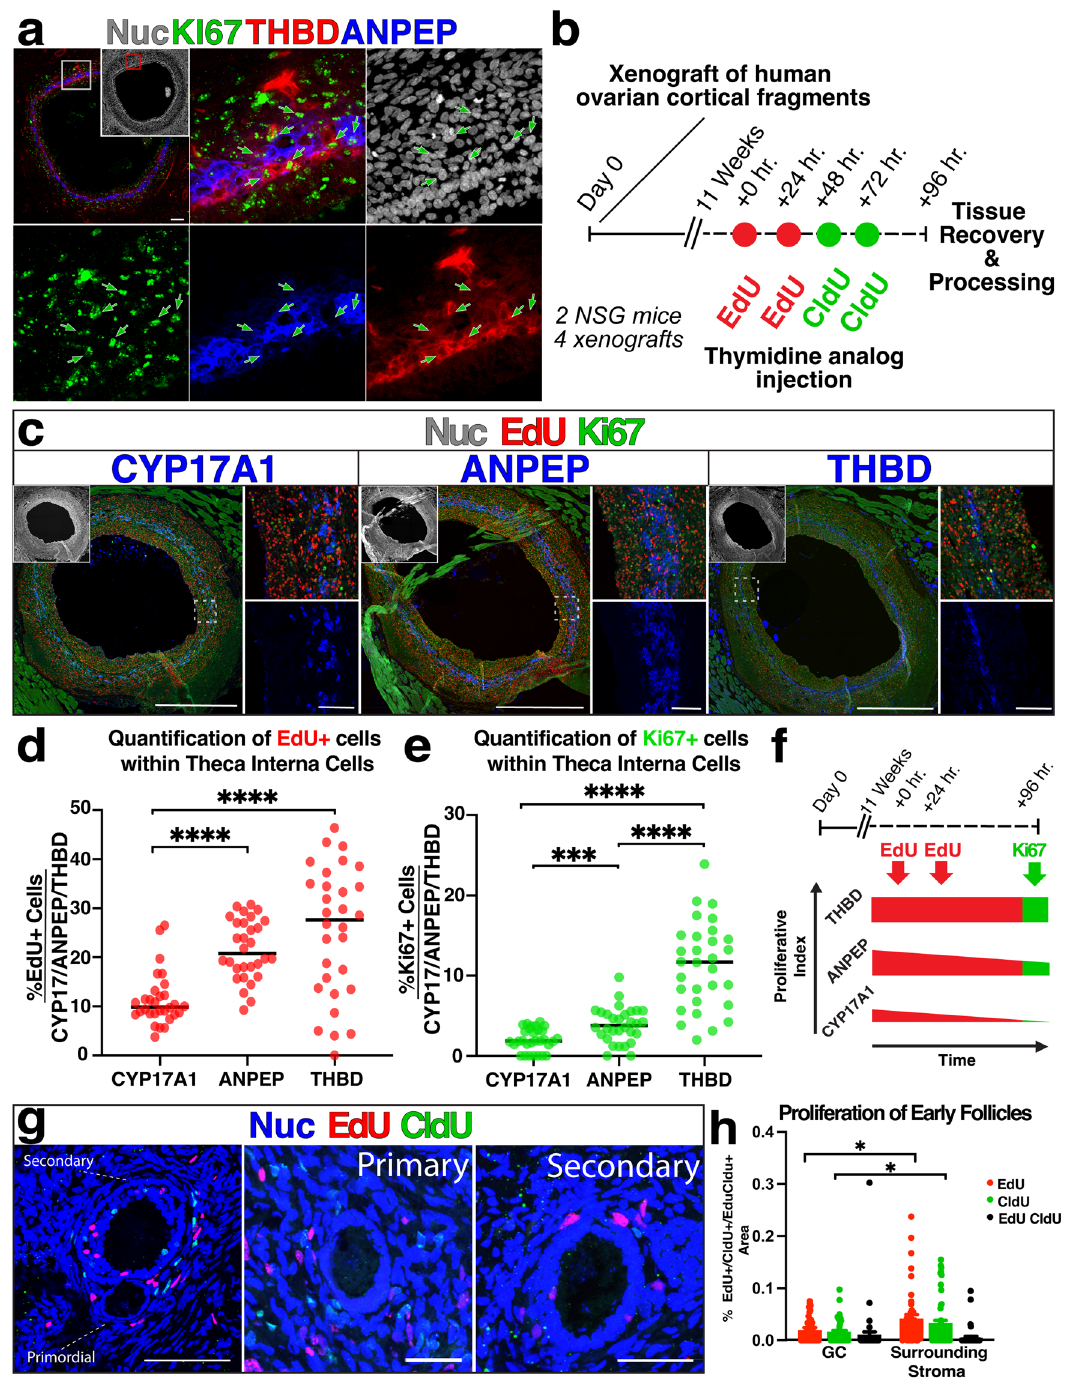
Fig. 4 Mitotic index of THBD + , ANPEP + and CYP17A1 + reveals decreased proliferation with acquisition of androgenic fate. a Representative staining for Ki67, THBD and ANPEP in antral follicles; green arrows indicate Ki67 + cells. b Schematic of experimental approach for sequential labeling with thymidine analogues; red and green dots indicate times of EdU and CldU injections, respectively. c – e Xenografted antral follicles labeled to detect EdU incorporation (red) ki67 (green) and either CYP17A1, ANPEP, or THBD as indicated (blue). Cells within the CYP17A1/ANPEP/THBD compartment that stained positive for EdU ( d ) or Ki67 ( e ) were quanti fi ed. f Schematized representation of proliferation among sub-populations in antral follicles. g Representative images of ovarian xenograft tissue containing pre-antral follicle stages immunolabeled for EdU (red) and CldU (green). h Quanti fi cation of proliferative cells within the GC and theca compartment of early follicles (primordial, primary, secondary <5 GC layers), as measured by incorporation of EdU (red bar), CldU (green bar) or both (black bar). Nuclear counterstain (DAPI) is shown in white in ( a and c ) and in blue in ( g ). Scale bars: in ( a ) – 100 μ m; in ( c ) large panels 1 mm, small panels 50 μ m; in ( g ) left panel – 100 μ m, Primary and Secondary panels – 50 μ m;. p values *<0.05, **<0.005, ***<0.0005,